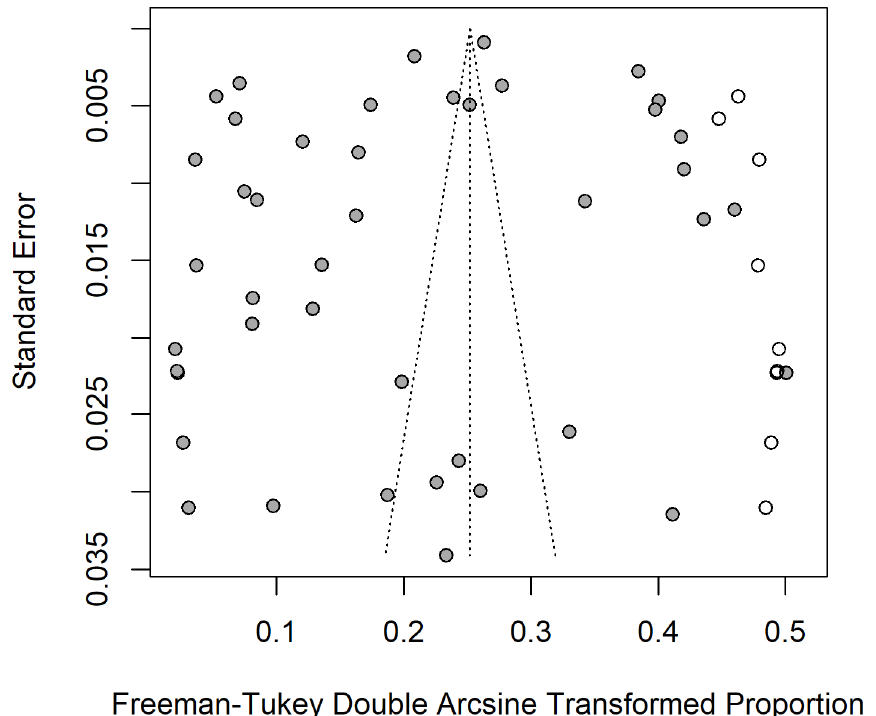
Figure 5. Funnel plot with trim and fill analysis of the publication bias in Trichinella spiralis infection in domestic pigs in in domestic pigs in China.